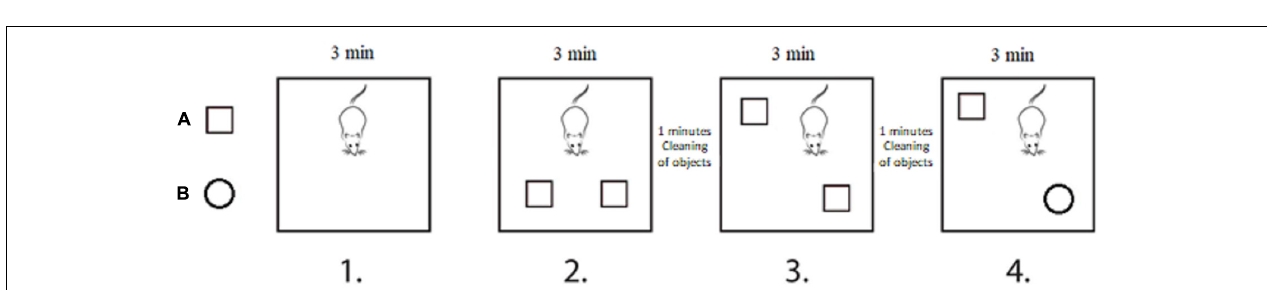
FIGURE 1 | Experimental design. The 18-month-old male and female rats underwent 5 weeks of whole body vibration intervention with a single daily session of 10 min exposure, five times per week. After 5 weeks, a test battery was performed to assess anxiety-like behavior, memory functions, and motor performance. The used MarodyneLiv plate is depicted in the upper left corner.